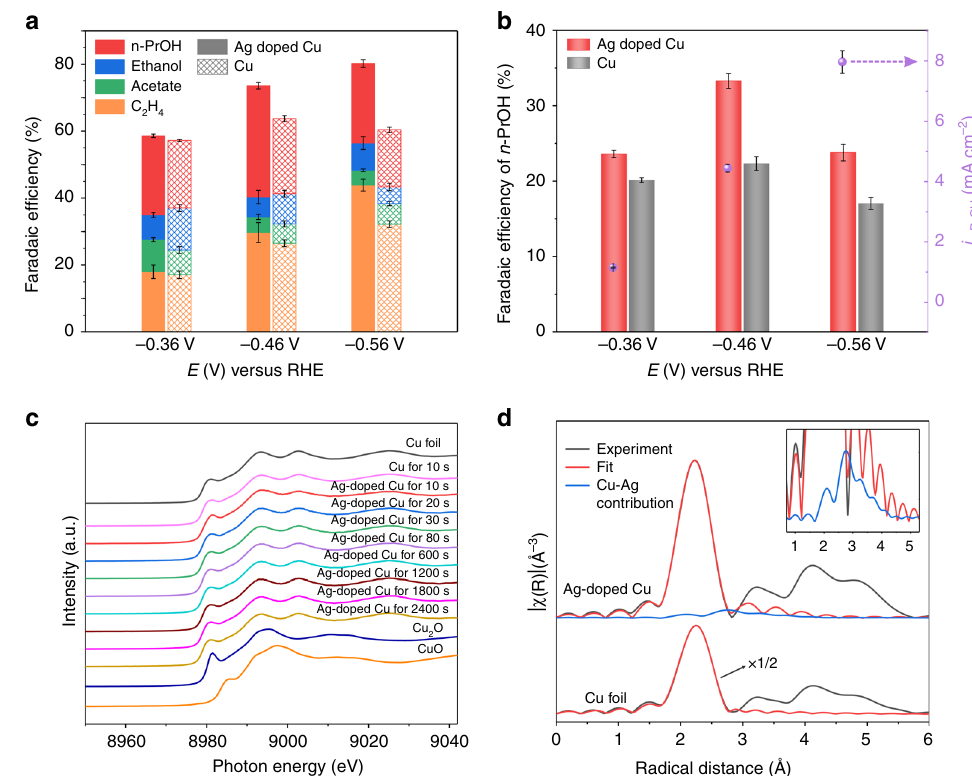
Fig. 3 CO electroreduction performance and operando structural characterizations of Ag-doped Cu catalyst in fl ow cell. a FEs of n -propanol ( n -PrOH), ethanol, acetate, and ethylene on Ag-doped Cu and pristine Cu catalysts under different potentials. b Comparison of n -propanol FEs on Ag-doped Cu and Cu GDE under different potentials, as well as partial current density of n -propanol formation on Ag-doped Cu GDE. Error bars represent the standard deviation based on three separate measurements. c Operando Cu K-edge XANES spectra of Cu GDE following 10 s and Ag-doped Cu GDE following 10, 20, 30, 80, 600, 1200, 1800, and 2400 s at − 0.46 V RHE during CORR. Bulk Cu foil, CuO, and Cu 2 O are listed as references. d Operando Cu K-edge EXAFS spectrum of Ag-doped Cu GDE following 10 s at − 0.46 V RHE during CORR. Bulk Cu foil was listed as a reference. Inset, an enlarged view of the section from 0.7 to 5.3 Å for Ag-doped Cu GDE